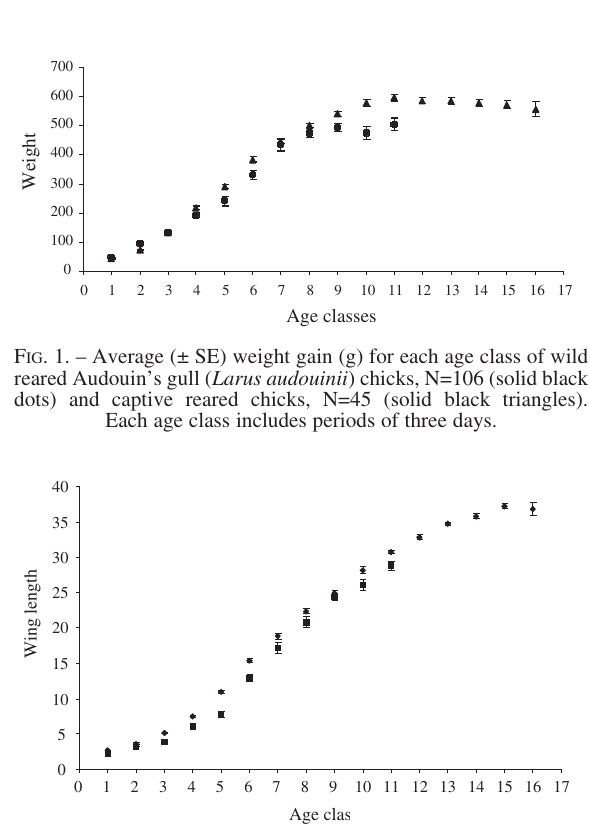
F IG . 2. – Average increase (± SE) of wing length (cm) for each age class of wild reared Audouin’s gull ( Larus audouinii ) chicks, N=106 (solid black dots) and captive-reared chicks, N=45 (solid black triangles). Each age class includes periods of three days.